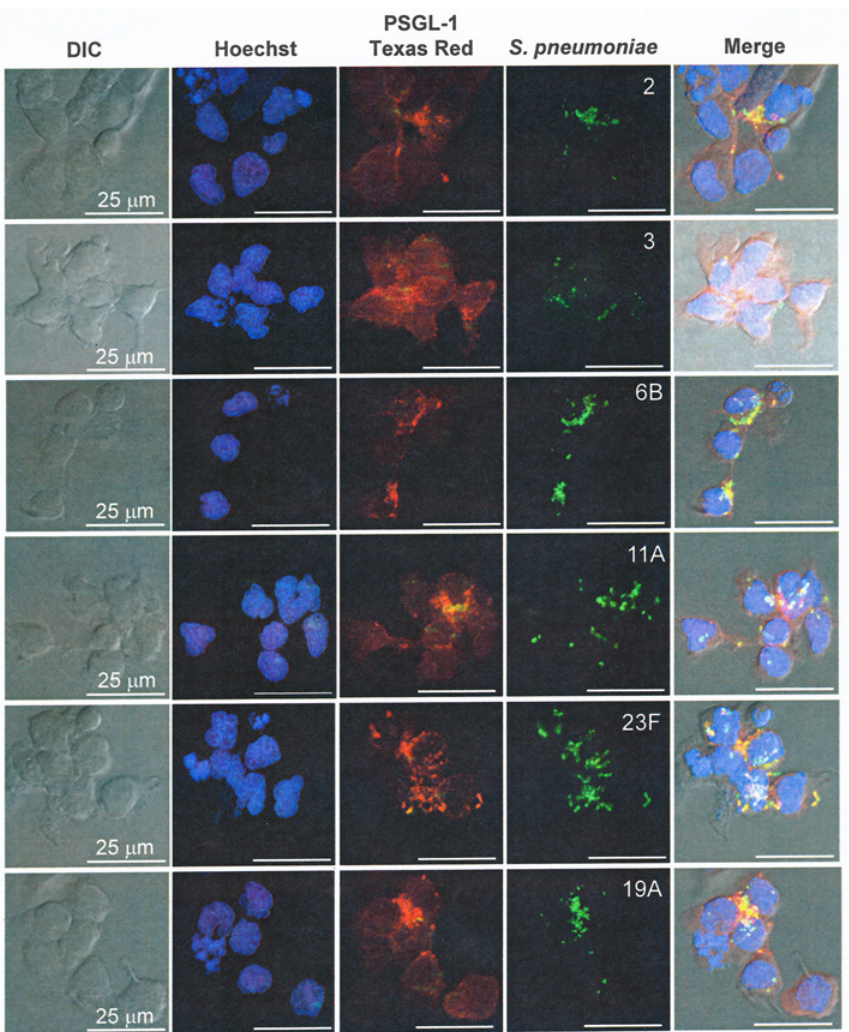
Cellular DNA was stained with Hoechst whereas PSGL-1 was visualized with mouse anti-human PSGL-1 antibody followed by a goat anti-mouse Texas-Red staining. (DIC, Differential interference